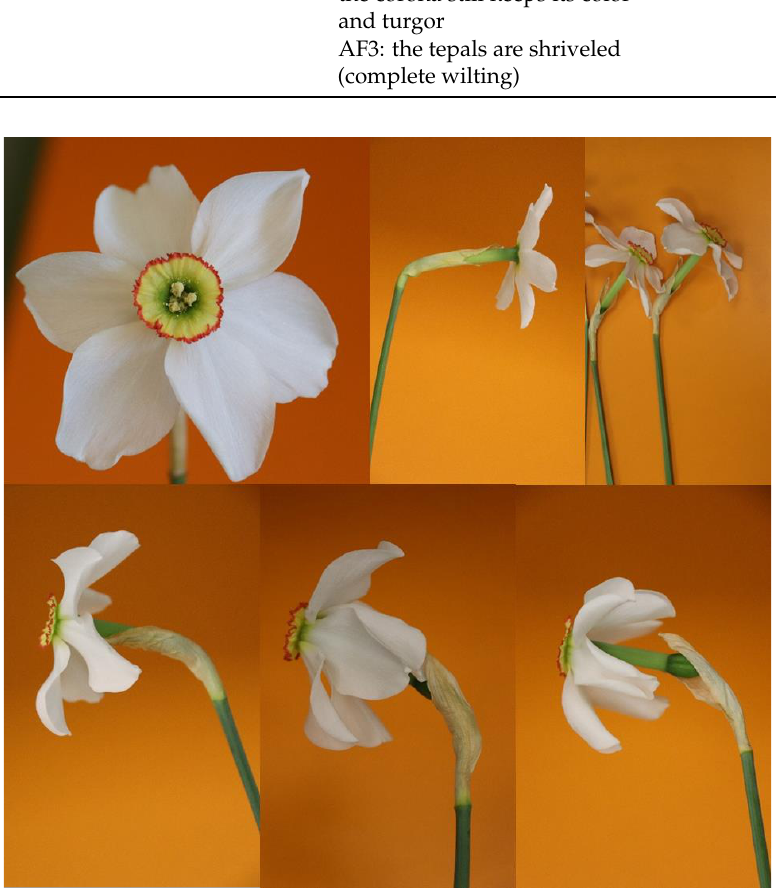
Figure 3. Variations of the open flower stage (upper row: FO — tepals are in a plane; bottom row: FOhb — tepals are standing half backwards (left); half of the petals are standing backwards (middle); FOh — tepals are standing backwards (right)).